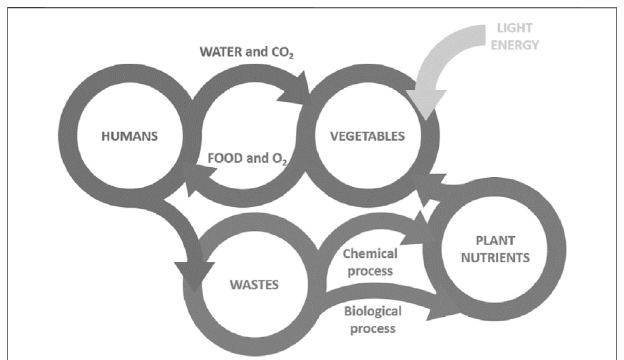
FIGURE 1 | Principal relationships in a bioregenerative life support system to support human habitation of remote outposts in space. Plants play an integral role by regenerating the atmosphere and recycling water while providing food for the crew.